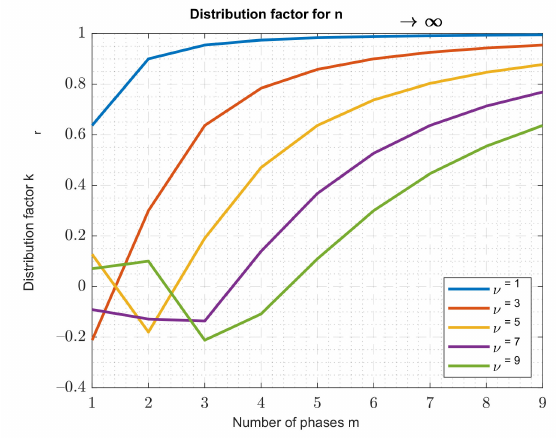
Figure 2. Distribution factor for different numbers of phases and spatial harmonics if n → ∞